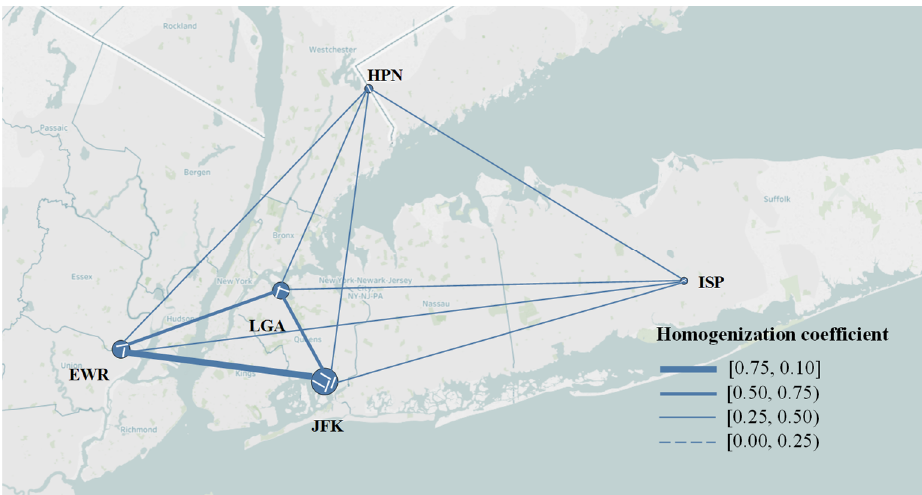
Figure 10. Illustrate of comprehensive homogenization of New York MAR.